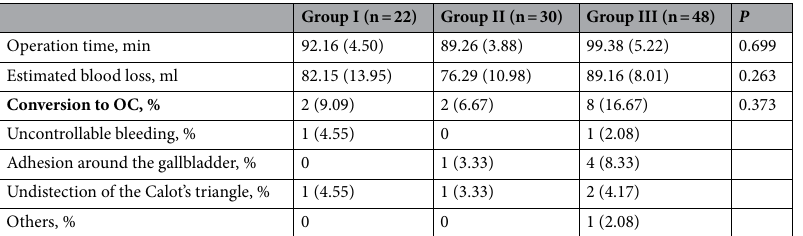
Table 3. Comparison of intraoperative outcomes. Values are presented as mean ± standard deviation or n(%). OC open cholecystectomy.